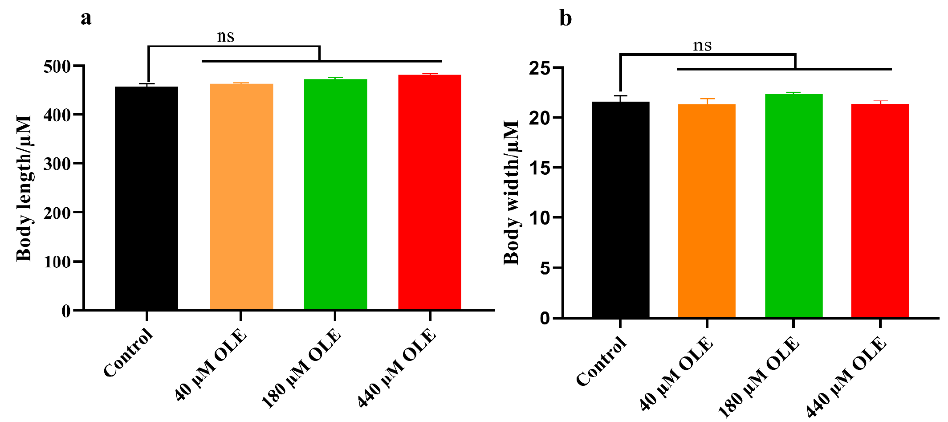
Figure 2. Effect of OLE on the body size of C. elegans . ( a ) Body length; ( b ) body